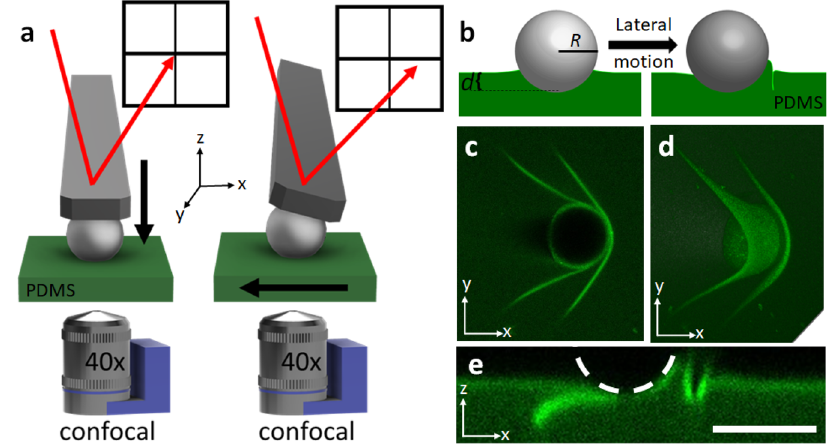
Fig. 1 | Experimental observations of a microparticle starting to be pulled laterally on a soft elastomer. a Schematic of the experimental setup showing the combined AFM cantilever and confocal microscope used to simultaneously image the contact and measure the lateral force. b Schematic of crease formation, also showing the experimental variables of depth, d , and radius, R . c A x – y confocal